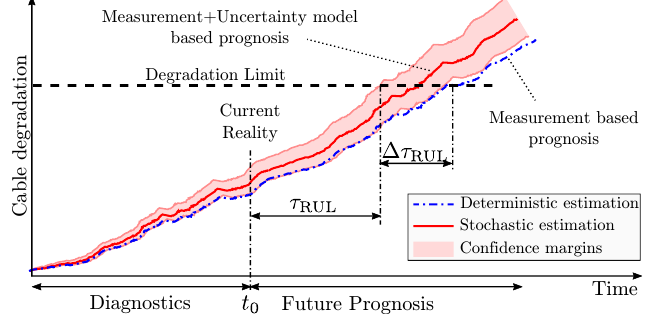
Figure 13. Effect of uncertainties on cable diagnostics and prognosis.